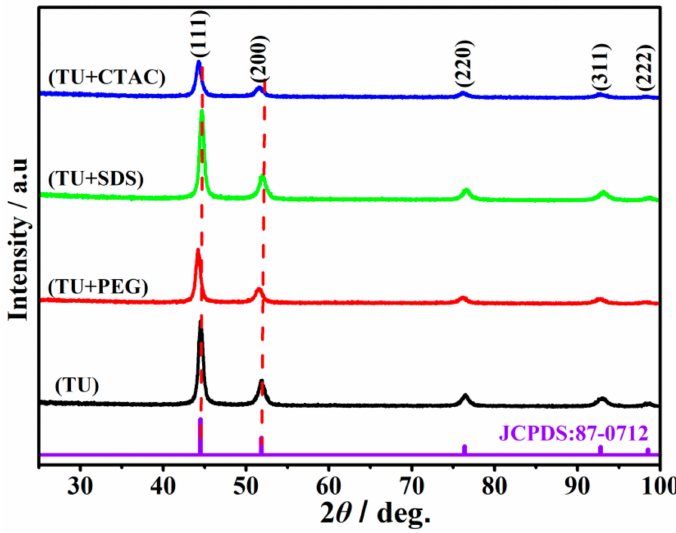
Figure 6. XRD patterns of nickel deposit in the presence of composite